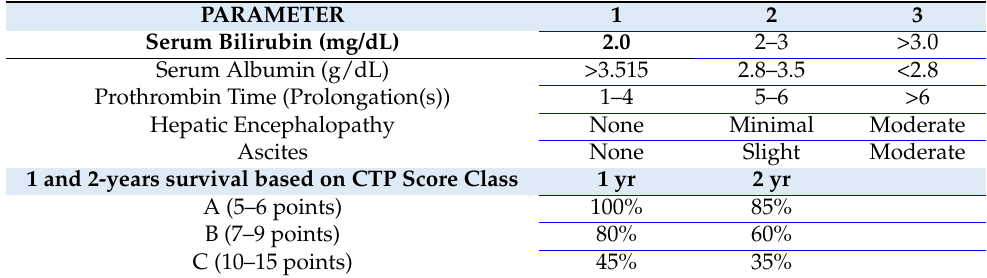
Table 1. Data from Child CG, Turcotte JG. Surgery and portal hypertension. In: Child CG. The liver and portal hypertension. Philadelphia: Saunders; 1964